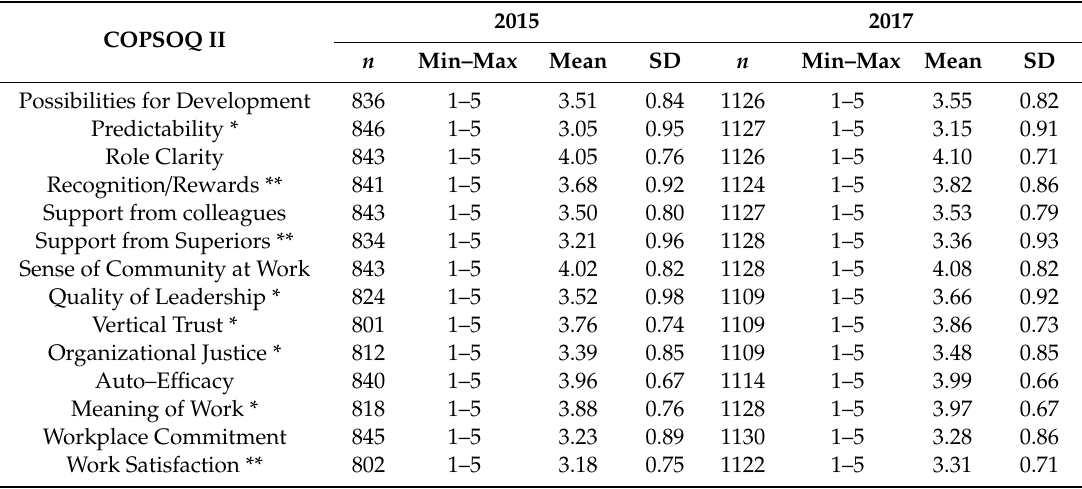
Table 6. Psychosocial factors among study participants in 2015 and 2017—COPSOQ II scales for which the higher value are